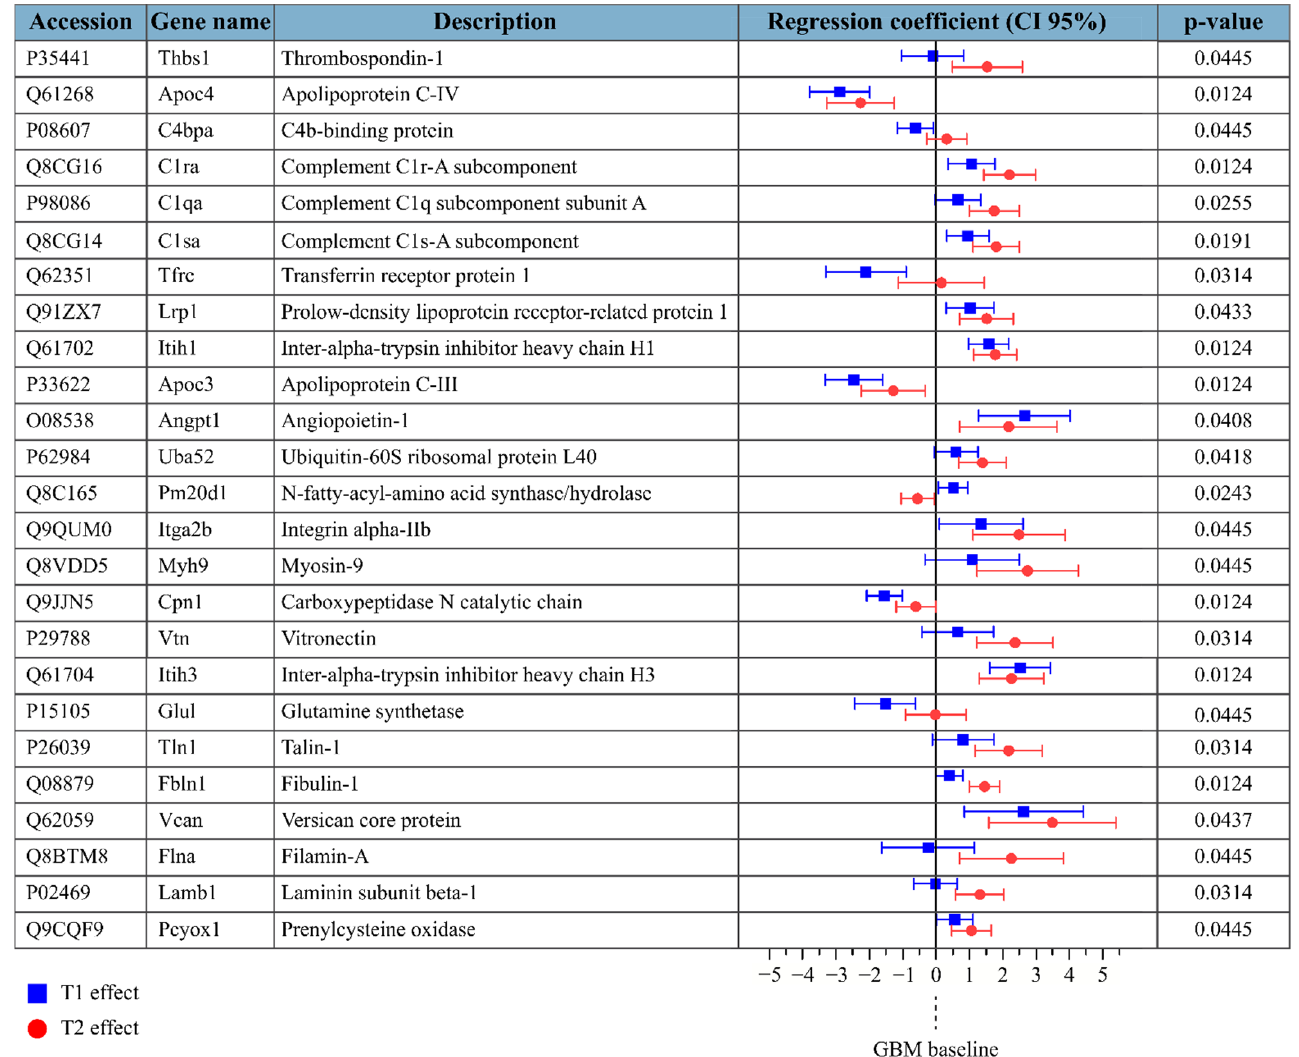
Figure 3. Protein groups that exhibited significant differences in the serum sEV dataset; p -values refer to the H0 hypothesis that all coefficients of the model are zero. Regression coefficients are reported in blue for a T1 (pre-symptomatic) effect and in red for a T2 (symptomatic) effect, with their confidence interval at 95%. Regression coefficients represent the fold change compared to the baseline.